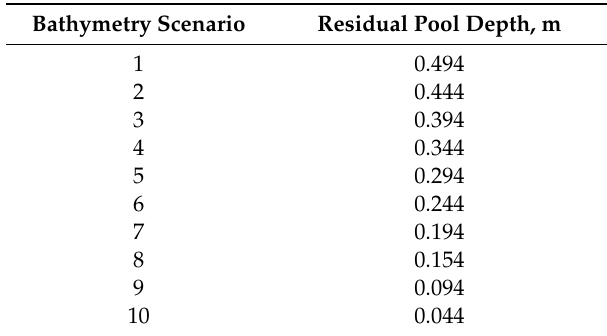
Figure 2. Pool-riffle structure and the geometric variables considered in the analysis (modified from Caamaño et al. [47]).